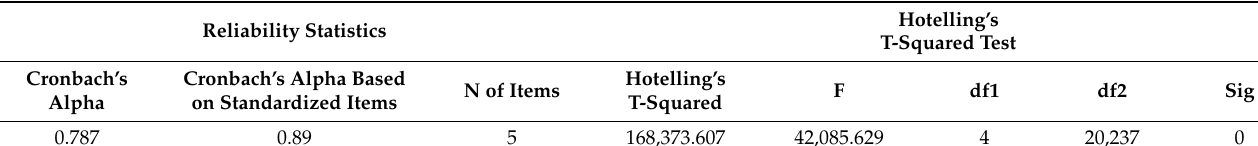
Table 4. Reliability statistics for data.